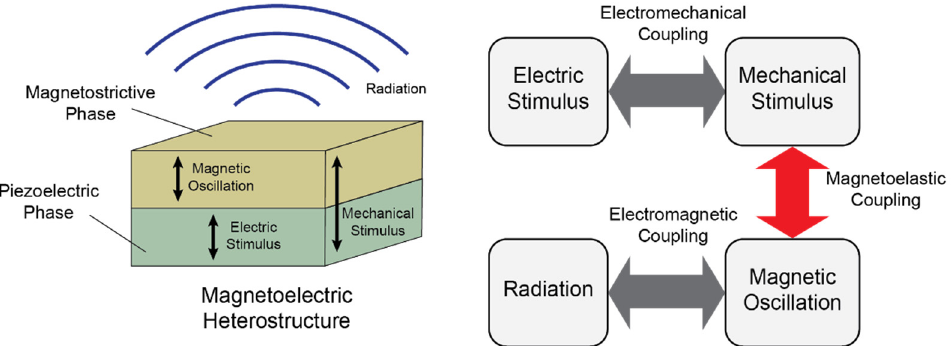
Figure 1. Heterostructure used for mechanically driven magnetoelectric antennas ( left ) along with operational flowchart ( right ) for electromagnetic wave radiation. Our work focuses specifically on an accurate analysis of the magnetoelastic coupling aspect of operation.